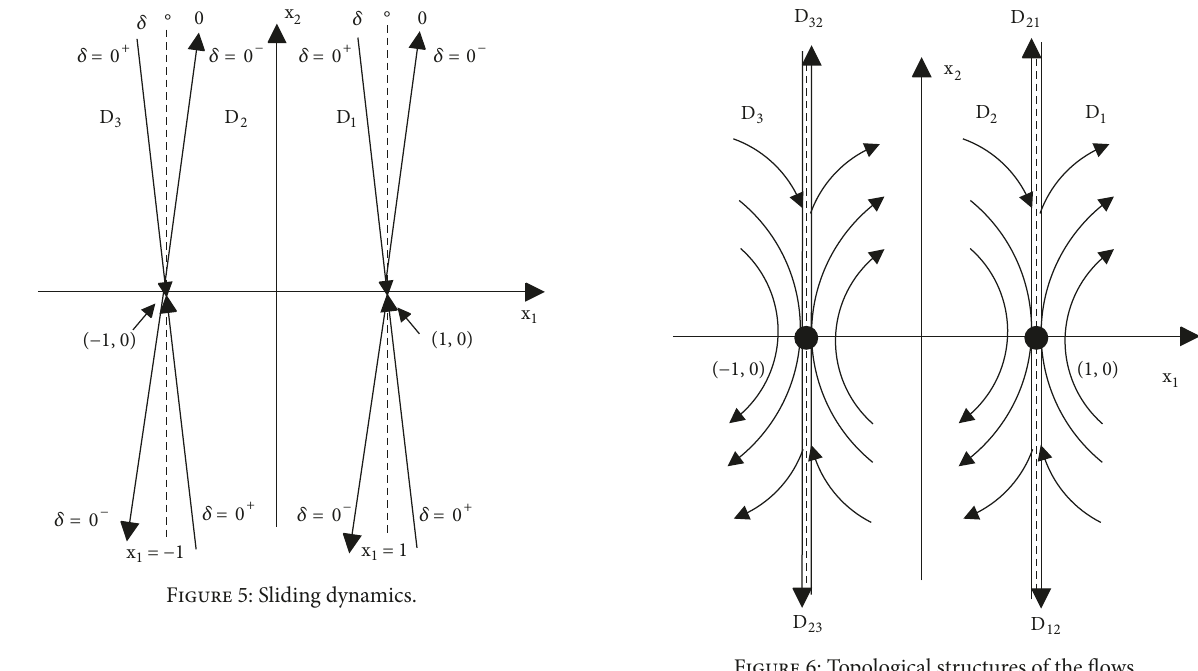
Figure 6: Topological structures of the